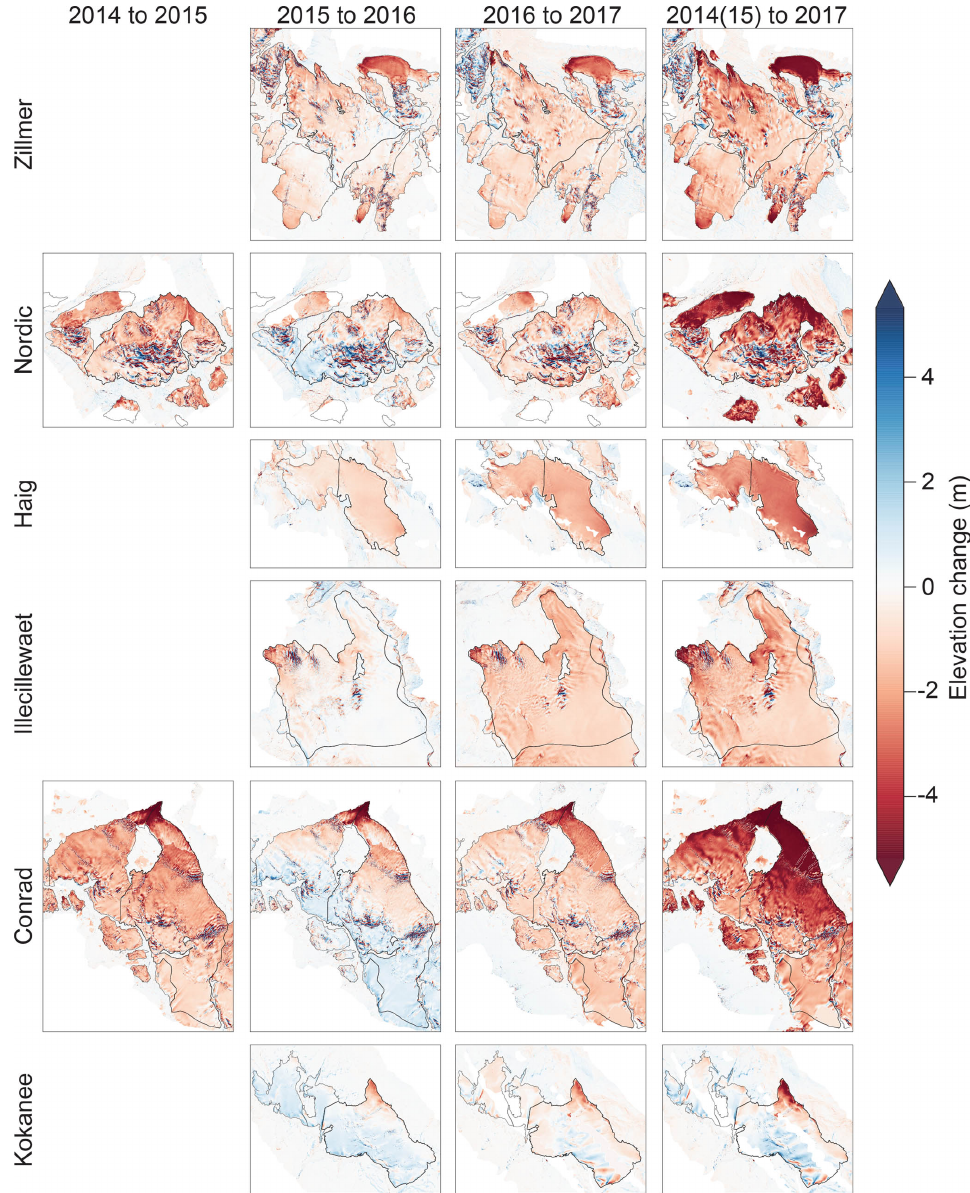
Figure 7. Surface height change for the Zillmer, Nordic, Haig, Illecillewaet, Conrad, and Kokanee glaciers from the first late summer DEM (2014 or 2015) until late summer 2017. Study glaciers are outlined with thick black line and other glaciers with a thin black line. Off-ice areas deemed stable terrain were used for error analysis and